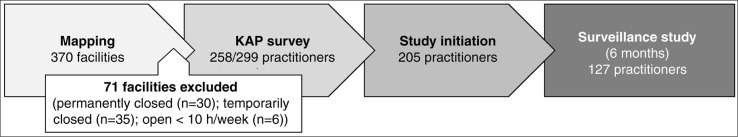
Selection process of reporting units for the surveillance study.